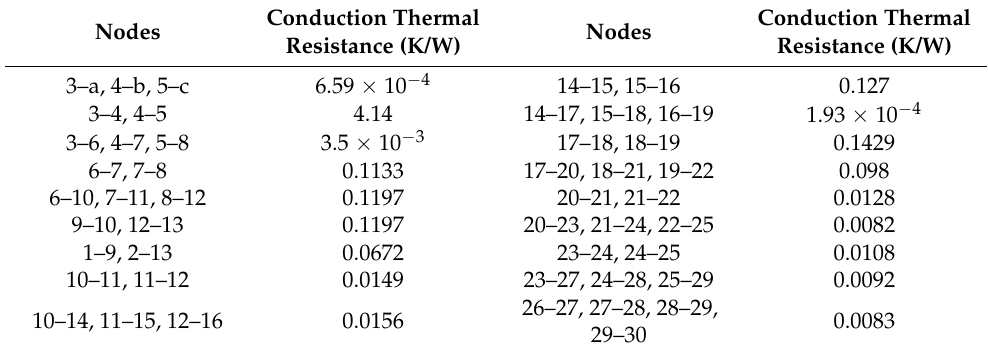
Table 3. Thermal resistance between nodes.